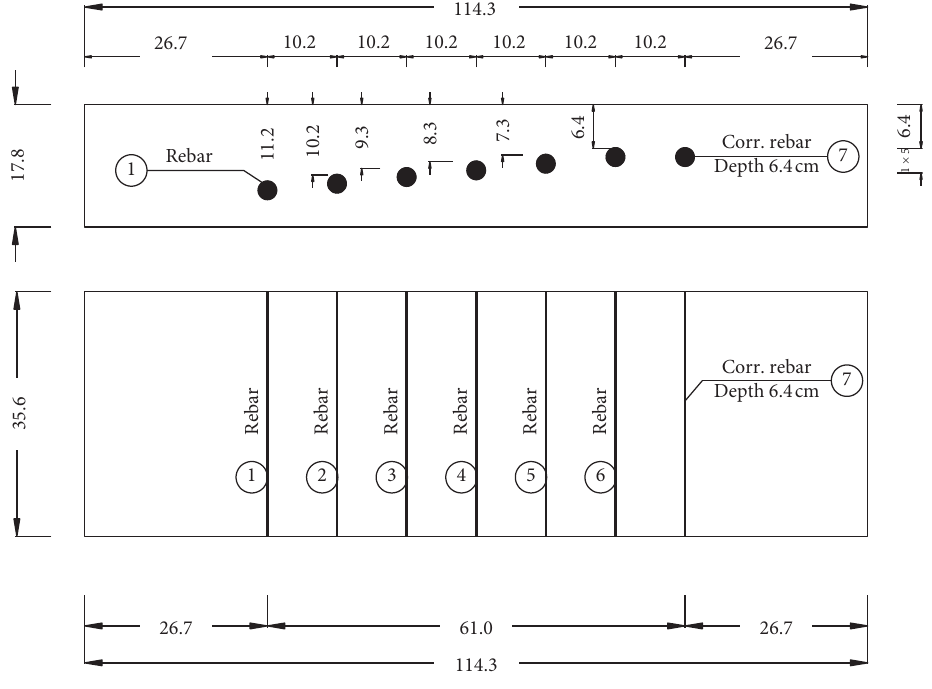
Figure 2: Configuration of reinforced concrete specimens. Table 2: Input parameters for the GPR data collection Table 1: Detailed slab specimens with different chloride con- tamination levels.